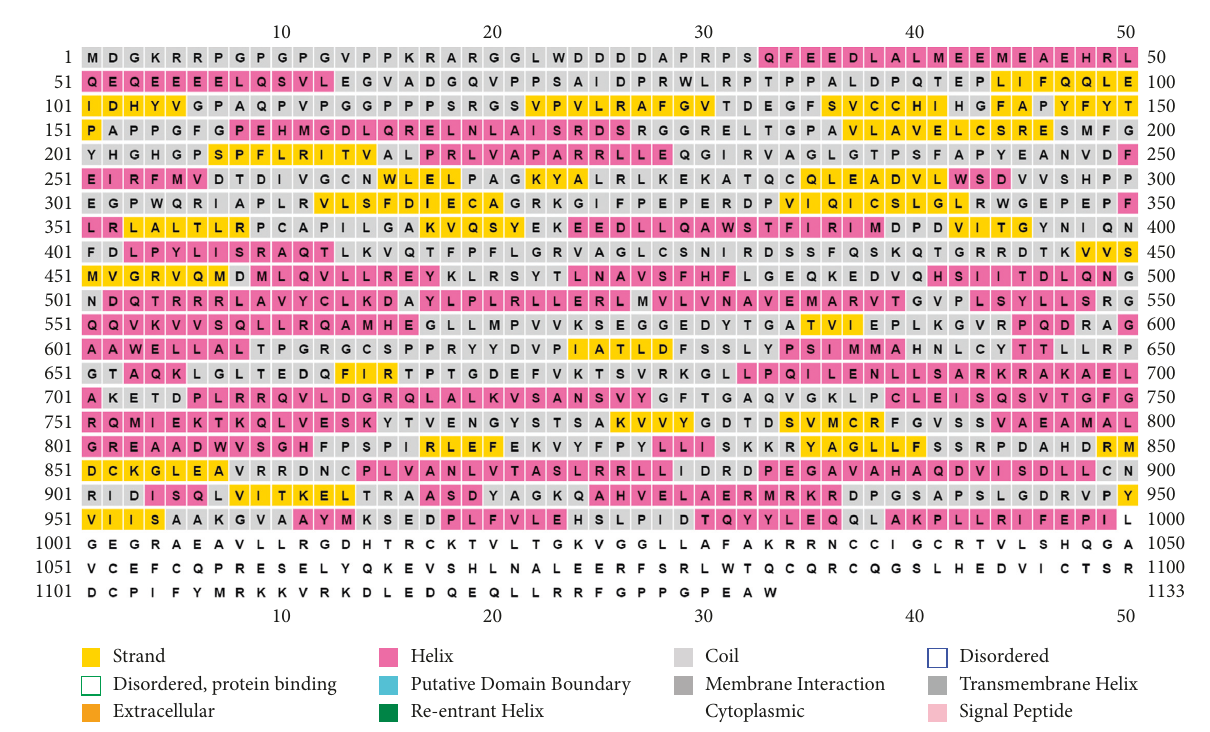
Figure 4: Secondary structure prediction result of POLD1.